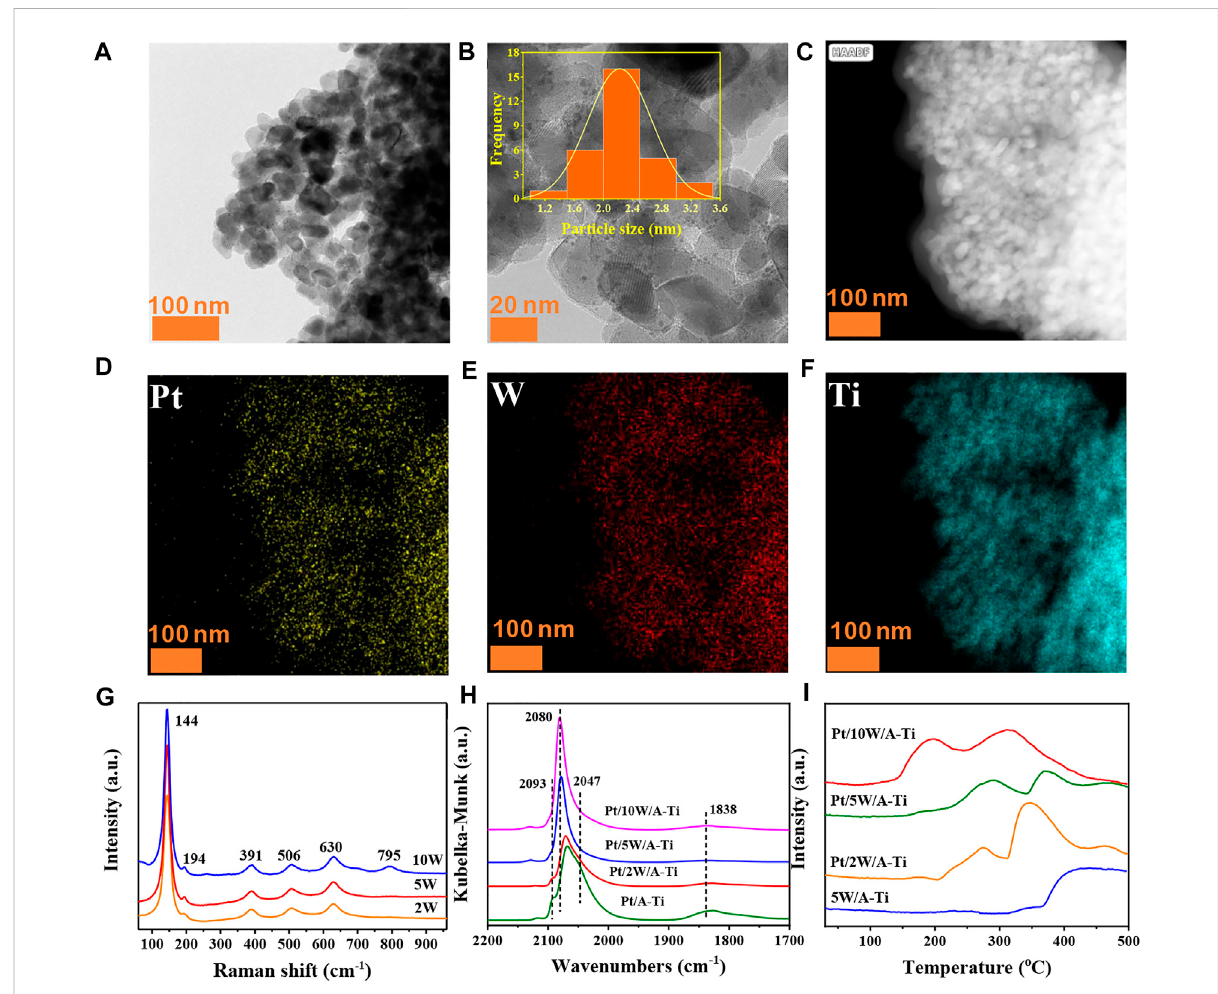
FIGURE 3 TEM image of the freshly reduced Pt/5W/A-Ti (A,B) , elemental mapping images of the freshly reduced Pt/5W/A-Ti (C – F) . Raman spectral pro fi les recorded for Pt/W/A-Ti (G) . DRIFTs of CO adsorption on the Pt/W/A-Ti catalysts prepared under conditions of varying W loadings (H) . H 2 - TPD curves recorded for the Pt/W/A-Ti series catalysts (I)